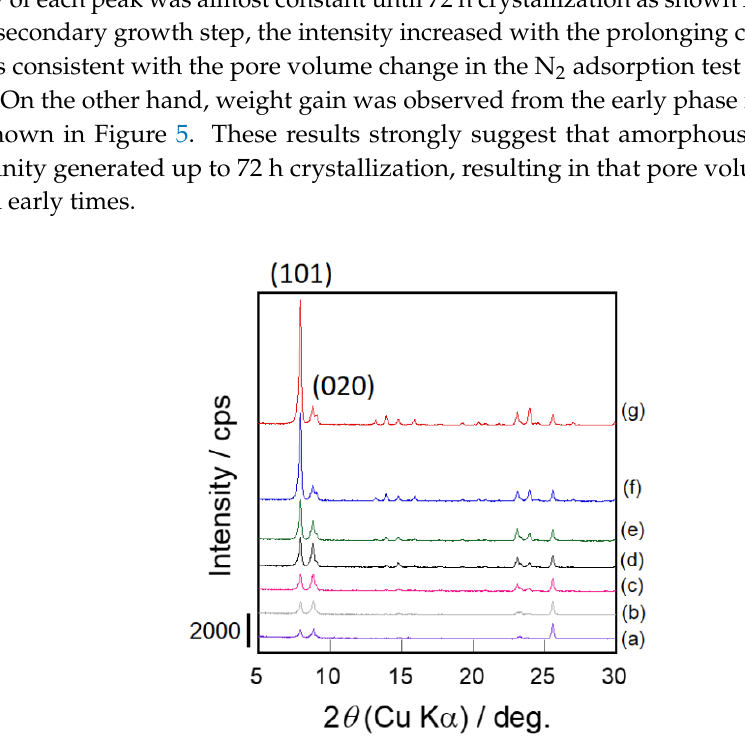
Figure 4. XRD patterns of ( a ) a seeded support and silicalite-1 membranes crystallized for ( b ) 24, ( c ) 72, ( d ) 120, ( e ) 168, ( f ) 252, and ( g ) 336 h.